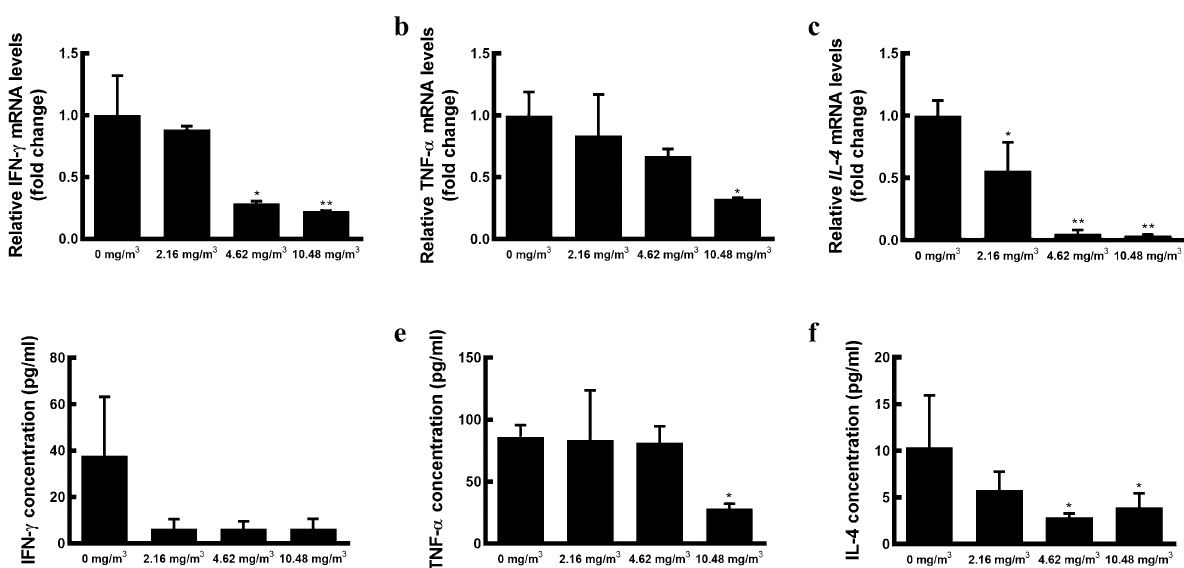
Figure 2. Helper T cell-related mRNA expression and cytokine production by FA exposure. Splenocytes isolated from FA-exposed minipigs were cultured with 2.5 μg/mL Concanavalin A (Con A) for 72 h. The mRNA expression of genes associated with Th1 ( IFN-γ, TNF-α ) and Th2 ( IL-4 ) was evaluated by qRT-PCR ( a – c ). Target gene expression was normalised to GAPDH expression and the expression is presented as fold change relative to the control group. Production of cytokines associated with Th1 (IFN-γ, TNF-α) and Th2 (IL-4) was evaluated ( d – f ). Data are presented as the mean ± SD from two independent experiments ( n = 2 minipigs/group). * p < 0.05, ** p < 0.01. FA